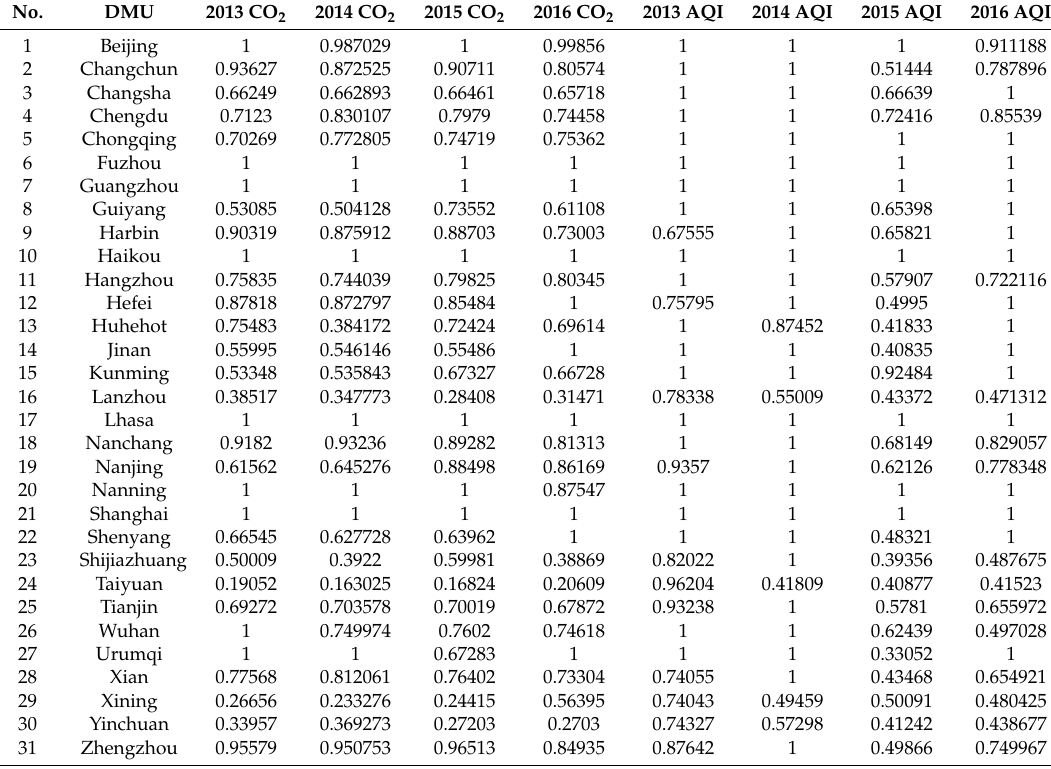
Table 7. 2013–2016 AQI treatment and carbon dioxide emission treatment efficiency